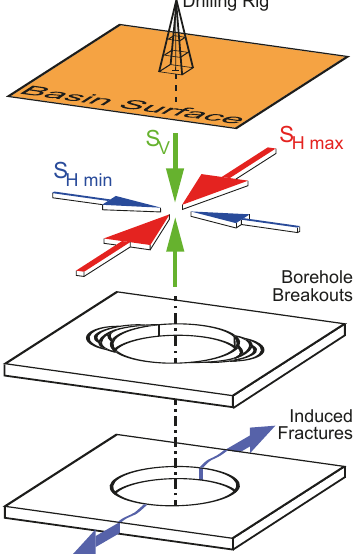
Figure 10. General assumption of stresses in sedimentary basins: the vertical stress ( S V ) is a principal stress, thus perpendicular to the minimum and maximum horizontal stress ( S hmin and S Hmax ). Borehole breakouts occur in orientation of the S hmin , and induced tensile fractures occur in orientation of S Hmax